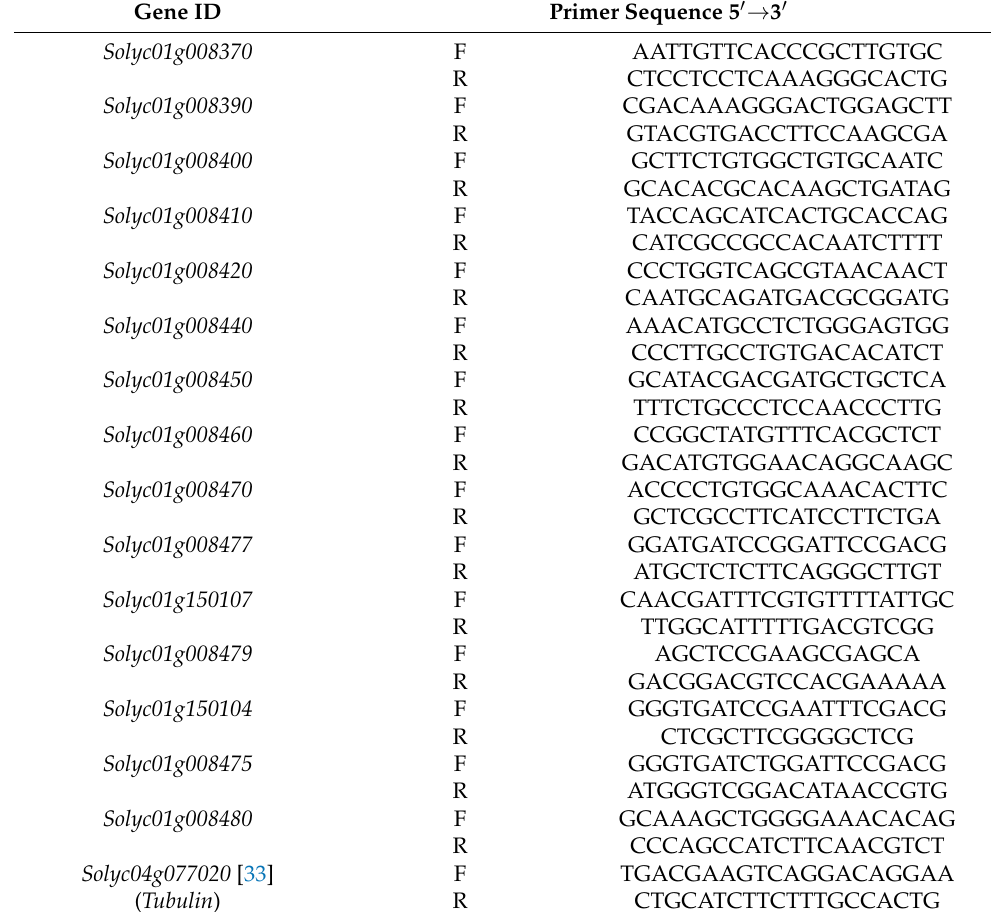
Table 1. Primers used for RT-qPCR. Gene